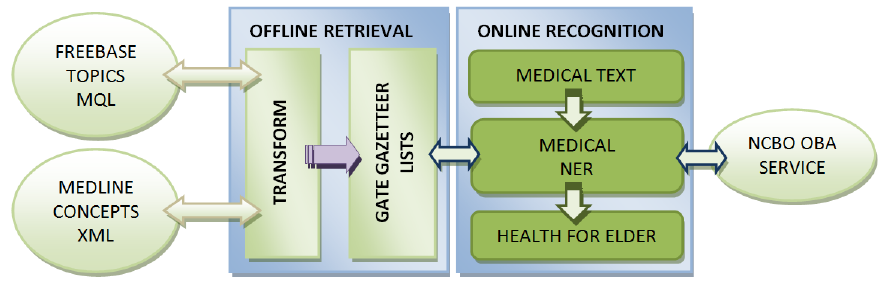
Figure 7. Health information service for elderly